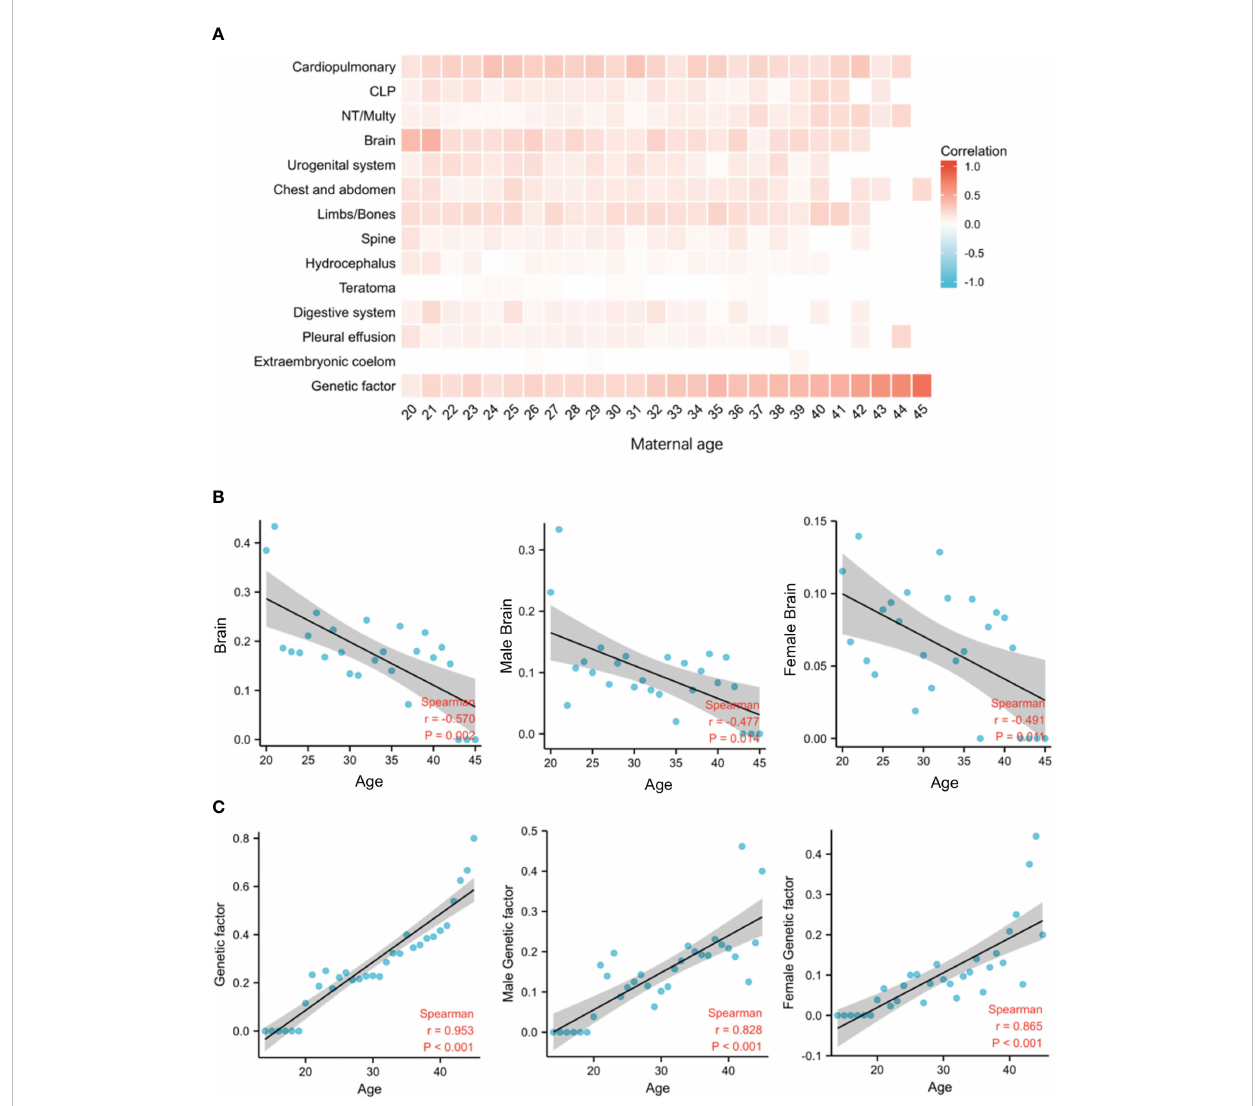
FIGURE 2 The relationship between malformations and maternal age. (A) Ratio of 13 types of structural malformations and maternal age. (B) The relationship between Brain-related malformations and arachnoid cysts (brain) and maternal age (total: r = 0.570, p = 0.002; male: r = 0.477, p = 0.014; female: r = 0.491, p = 0.011). (C) The relationship between genetic factor and maternal age (total: r = 0.95 3 , p < 0.001; male: r = 0.828, p < 0.001; female: r = 0.865, p <